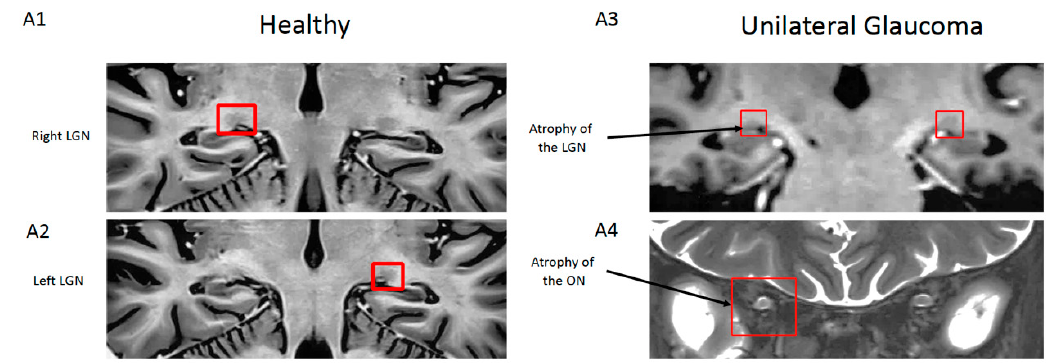
Figure 2. Magnetic resonance imaging (MRI) images of a coronal section of the brain of a healthy control and a unilateral glaucoma patient. Red squares localize the lateral geniculate nucleus (LGN) and optic nerve. MRI images from the patient show unilateral hyperintensity and atrophy of the right optic nerve (ON) and associated ipsilateral atrophy of the lateral geniculate nucleus compared to the healthy subject (from Dr. Habas Neuroimagerie XV-XX hospital; 3T SIEMENS Skyra MRI). ( A1 , 2 ) Coronal contrast-inverted short-TI inversion-recovery (STIR) images of LGN. ( A3 ) Coronal T1 weighted gradient-echo (MPRAGE) images of LGN. ( A4 ) Coronal STIR image passing through the intraconal optic nerve.